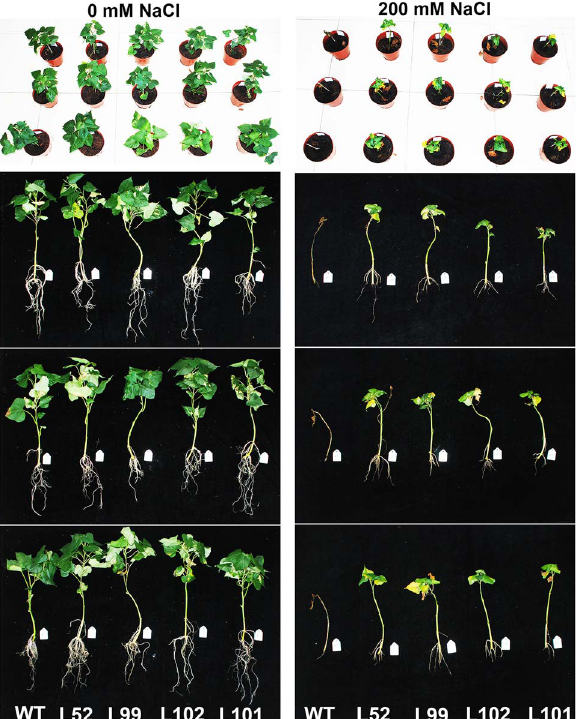
Fig. 7. Phenotypes of the IbMas -overexpressing sweetpotato plants grown in pots under 200 mM NaCl stress. The 25-cm-long cuttings of the salt-tolerant transgenic plants (L52, L99, L102 and L101) and wild-type plants (WT) were grown in 19-cm diameter pots containing a mixture of soil, vermiculite and humus (1:1:1, v/v/ v) in a greenhouse, with one cutting per pot. All pots were irrigated sufficiently with half-Hoagland solution for 10 days until the cuttings formed new leaves, and then each pot was irrigated a 200 mL of 0 and 200 mM NaCl solution, respectively, once every 2 days for 4 weeks. All of L52, L99, L102 and L101 plants showed good growth and increased physical size and those of WT died under 200 mM NaCl